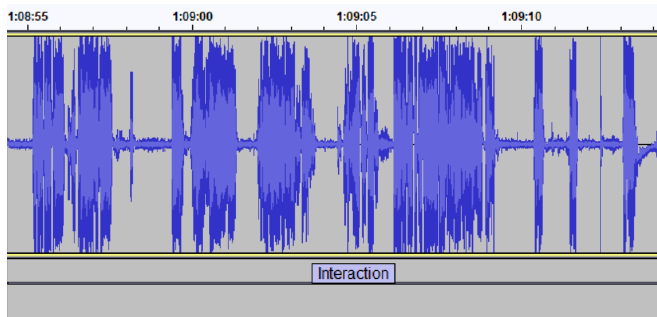
Figure 5. Audio sample of an Interaction segment. Table 4. Transcription of Figure 5.